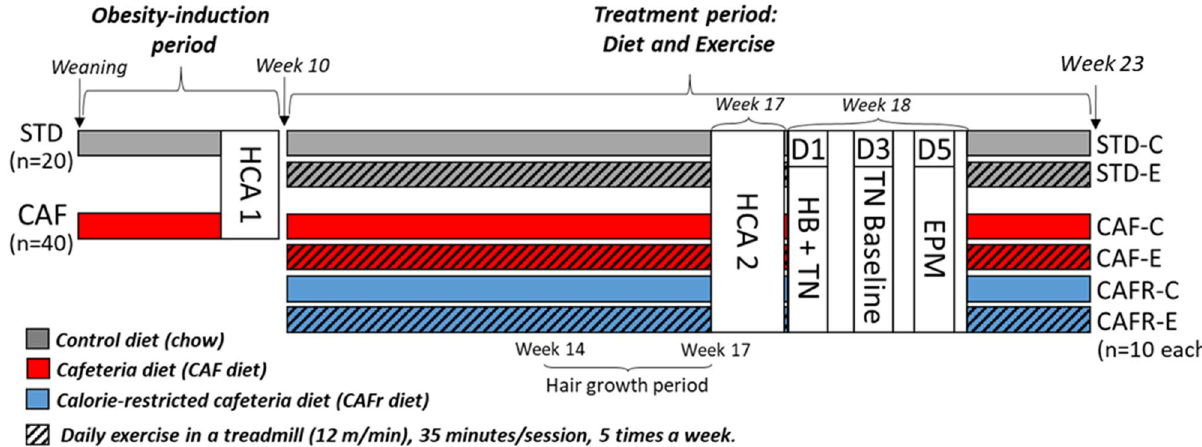
Figure 1. Experimental design showing groups, diets, and behavioral tests. Hair growth period refers to the period in which hair was allowed to regrow to be collected for the hair corticosterone study, see “Hair corticosterone” for details. HCA Home-Cage Activity; HB Hole Board; EPM Elevated Plus Maze; TN Tail